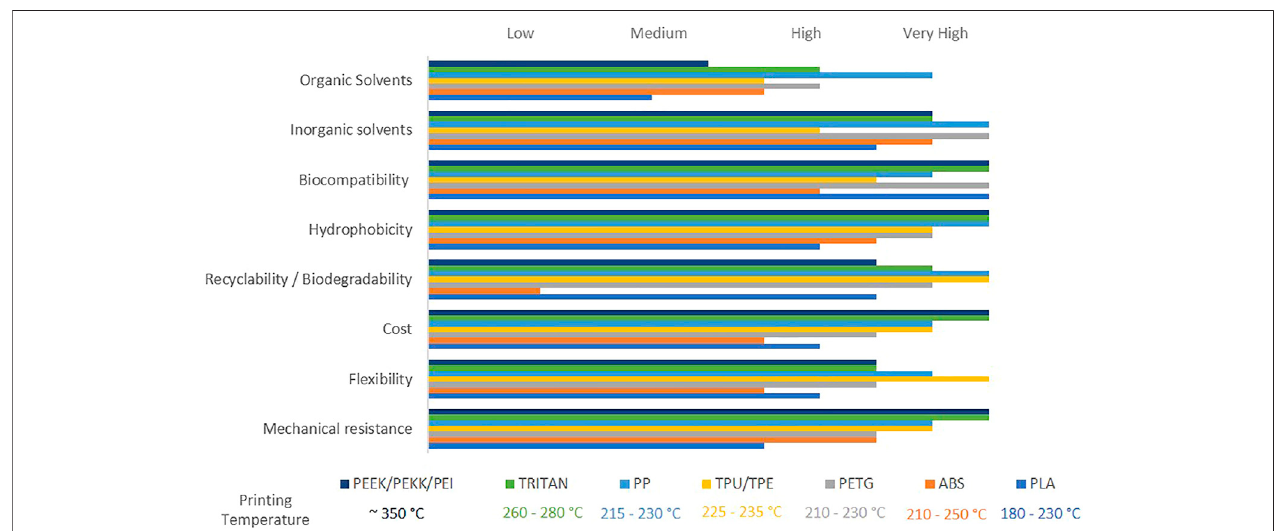
FIGURE 2 | Graphical representation of features of the raw polymeric materials used for FFF 3D printing (Source: Produced by the author from the data in Erokhin et al., 2019; Ligon et al., 2017; Appropedia.org; and the fabricants Rosemount Analytical Inc. and Curbell plastics).